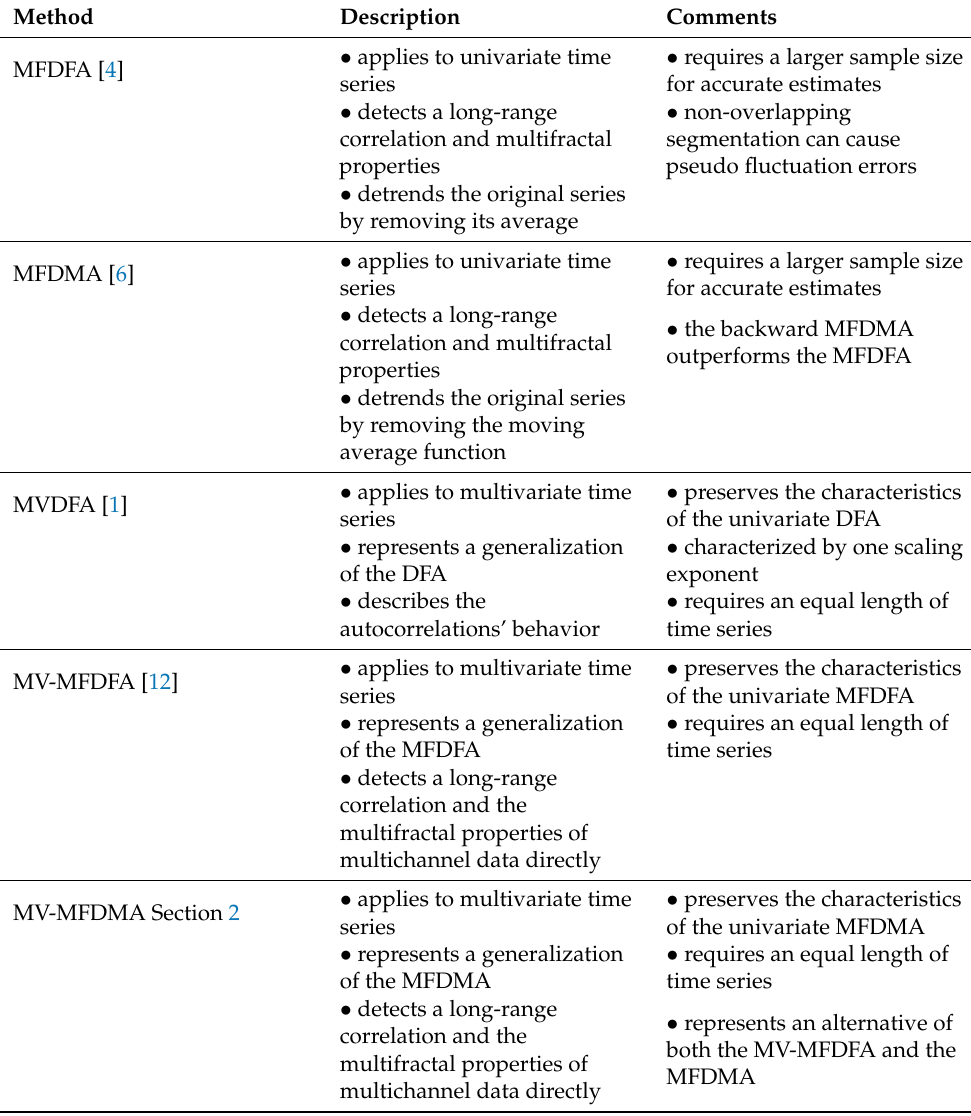
Table 1. Comparison of the algorithms for detecting